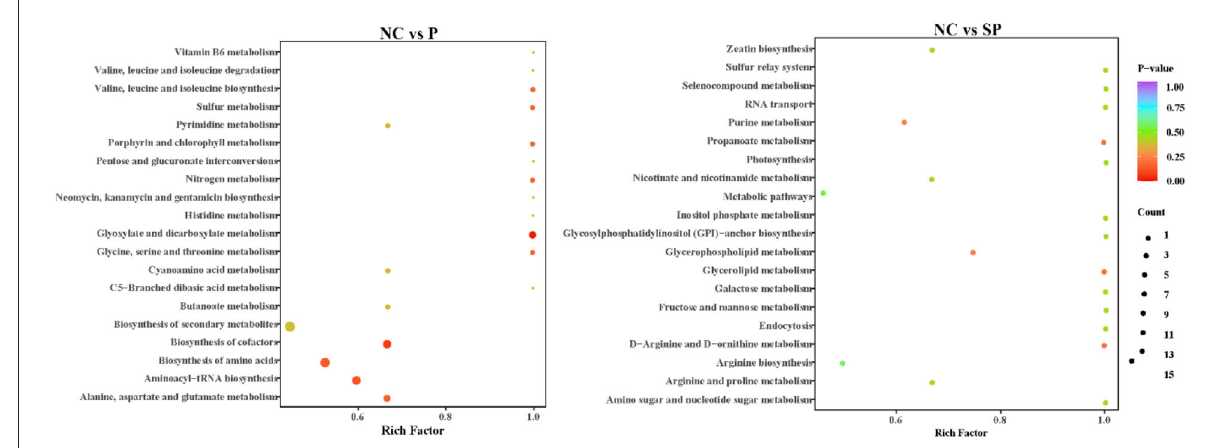
FIGURE8 KEGG pathways significantly enriched in differential metabolites.